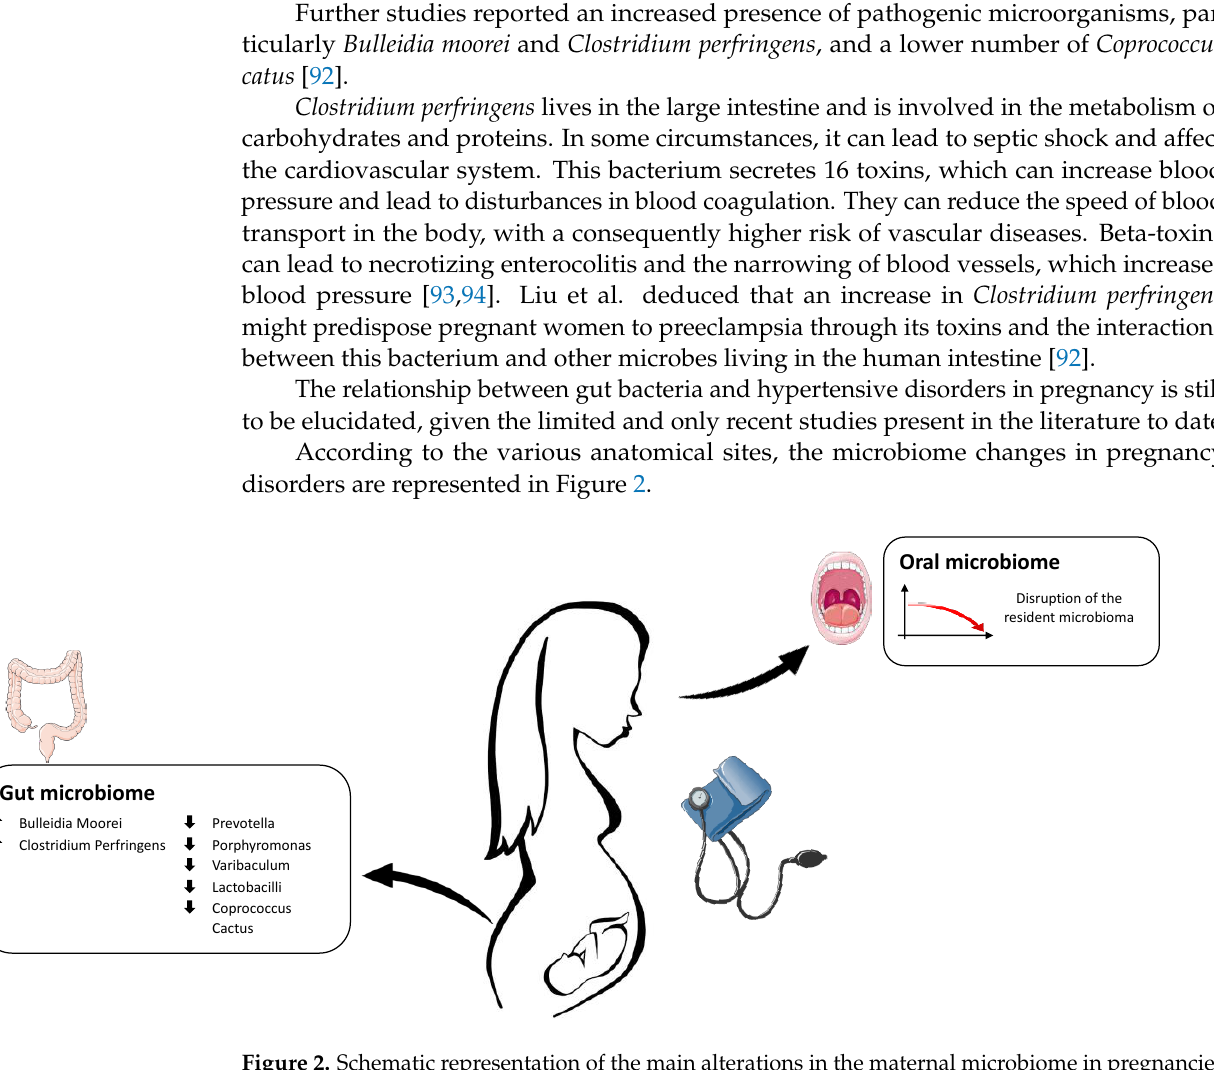
Figure 2. Schematic representation of the main alterations in the maternal microbiome in pregnan-